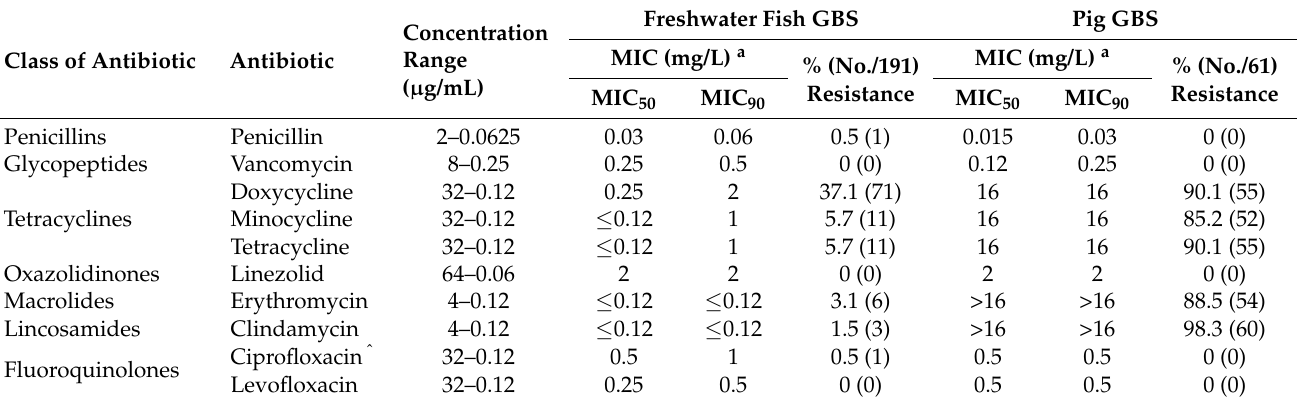
Table 2. Minimum inhibition concentrations (MICs) of GBS against 11 antibiotics.